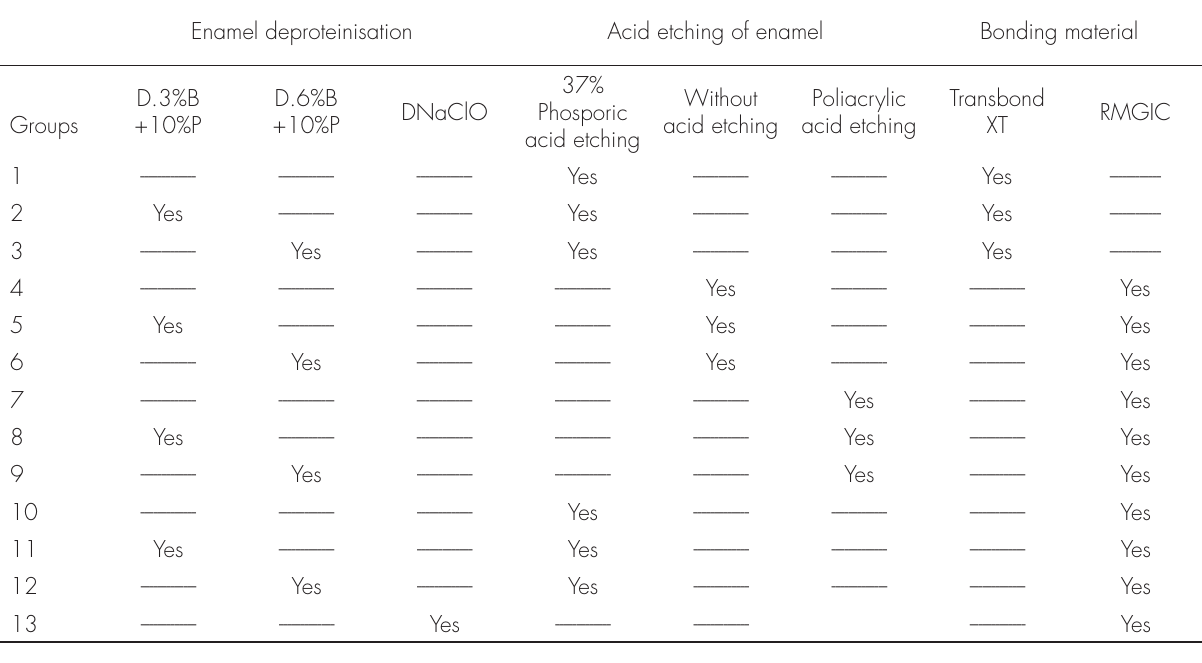
Table I. Experimental